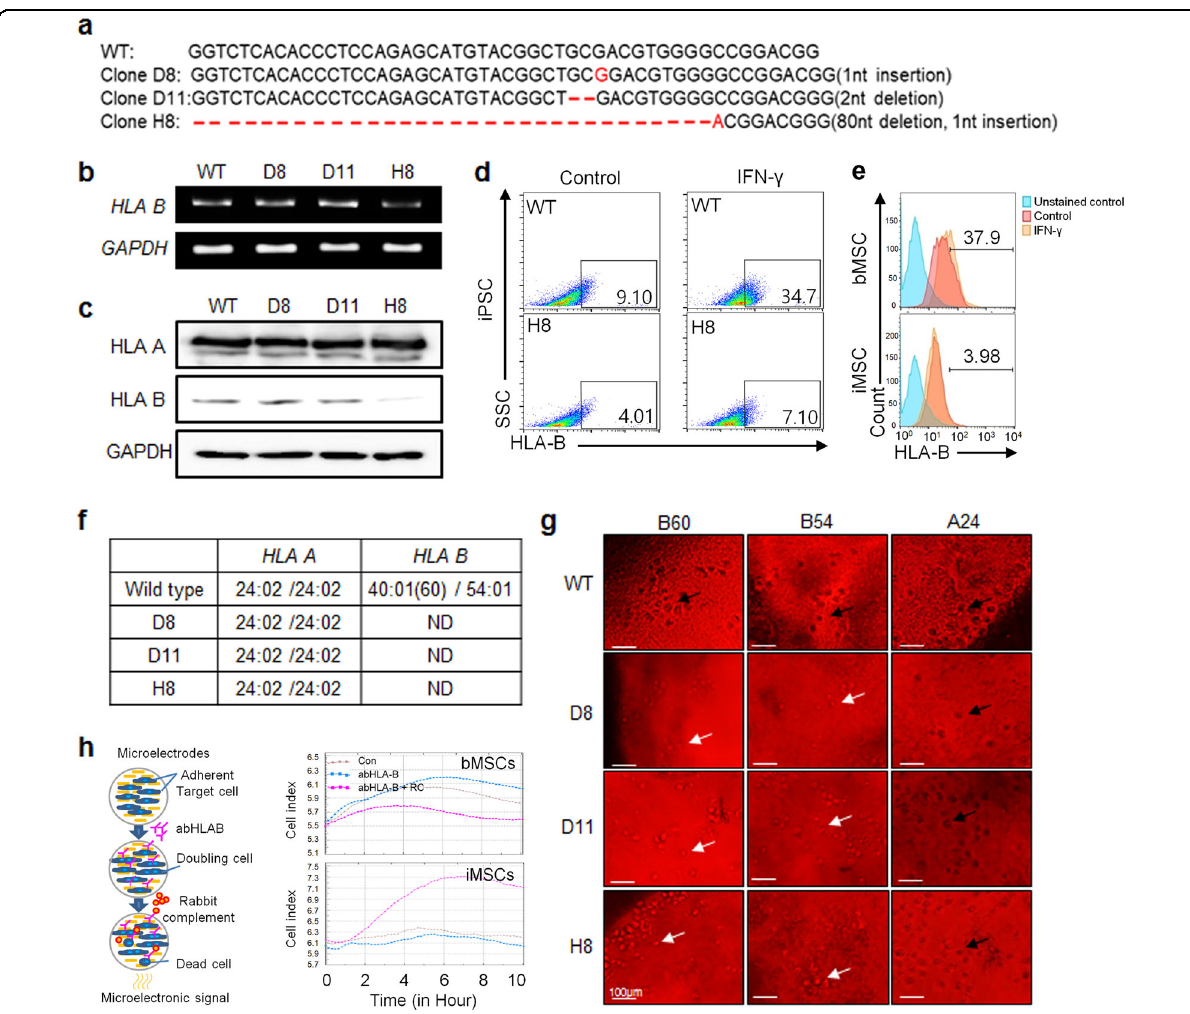
Fig. 2 HLA-B sequence and immunogenicity analysis of CRISPR-engineered inducible pluripotent stem cells. a Nucleotide sequence analysis of HLA-B – engineered iPSC clones. Expression analysis of HLA-B in HLA-B-engineered iPSC clones at the b mRNA and c protein levels. The fl ow cytometric analysis of HLA-B-expression in d wild-type and HLA-B-engineered iPSCs and e HLA-B-engineered iPSC-derived MSCs. The cells were unstimulated or stimulated with IFN- γ for the induction of HLA-B overexpression. bMSCs were used as the control. f HLA-typing analysis of HLA-B- engineered iPSC clones. HLA typing was performed with sequence-based typing (SBT). (ND; not determined). g Complement-dependent cytotoxicity analysis of HLA-B-engineered iPSC clones. To analyze complement-dependent cytotoxicity, serological HLA-B typing was performed using Terasaki HLA Tissue Typing Trays. For complement-dependent cytotoxicity, the cells were incubated with HLA – A (*24) or – B (*54 or *60) speci fi c antiserum. Living and dead cells were determined by eosin staining. Black arrows represent dead cells. White arrows indicate live cells. h X-celligence scheme (left panel). Antibody-dependent cellular cytotoxicity (ADCC) of HLA-B-engineered iPSC-derived MSCs using x-celligence (right panel). bMSCs were used as the